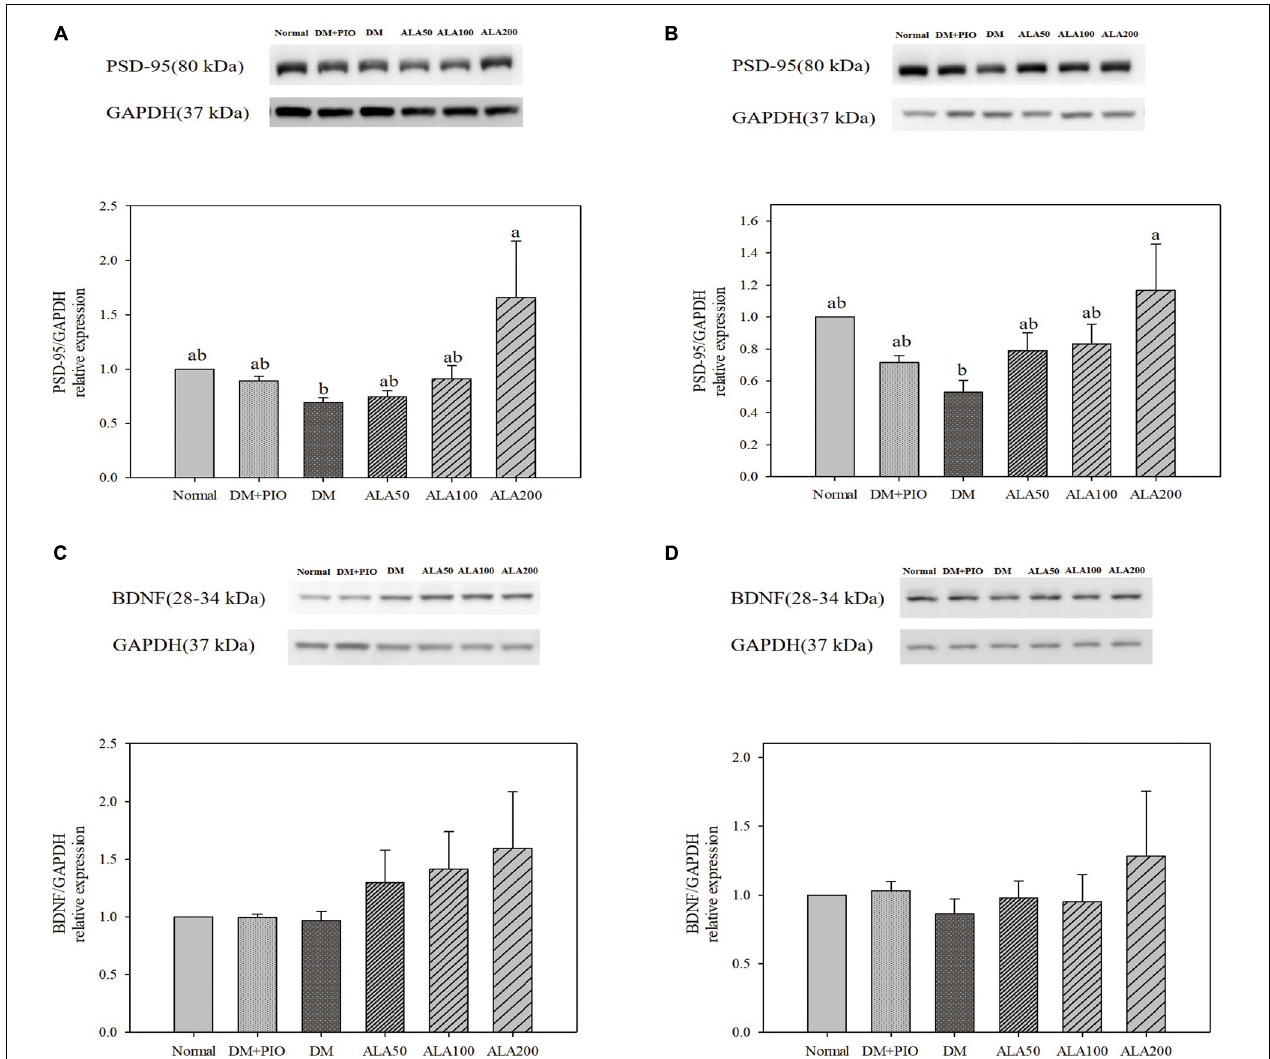
FIGURE 5 | Protein levels of PSD-95 in the hippocampus (A) and cortex (B) , and BDNF levels in the hippocampus (C) and cortex (D) in high-fat diet and streptozotocin-induced type 2 diabetic rats treated with alpha-lipoic acid for 13 weeks. Normal, Normal diet; DM, high-fat diet (HFD; 60% fat) with STZ (30 mg/kg body weight, i.p.) induced diabetic rats; DM + Pio, DM rats gavaged with pioglitazone (30 mg/kg body weight) for 13 weeks; DM + ALA50, DM rats gavaged with ALA (50 mg/kg body weight) for 13 weeks; DM + ALA100, DM rats gavaged with ALA (100 mg/kg body weight) for 13 weeks; DM + ALA200, DM rats gavaged with ALA (200 mg/kg body weight) for 13 weeks. Values were calculated as the mean ± SEM, n = 6 for each group. a–c letter is significantly different among all samples tested ( p <